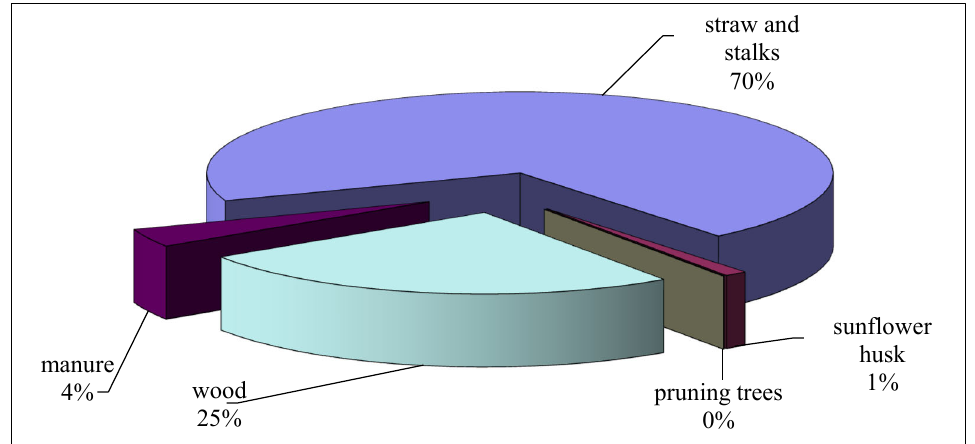
Figure 5. Structure of energy potential of the agricultural production in the Kyiv region, 2019. Source: Own calculations based on statistics from the State Service of Statistics [53].